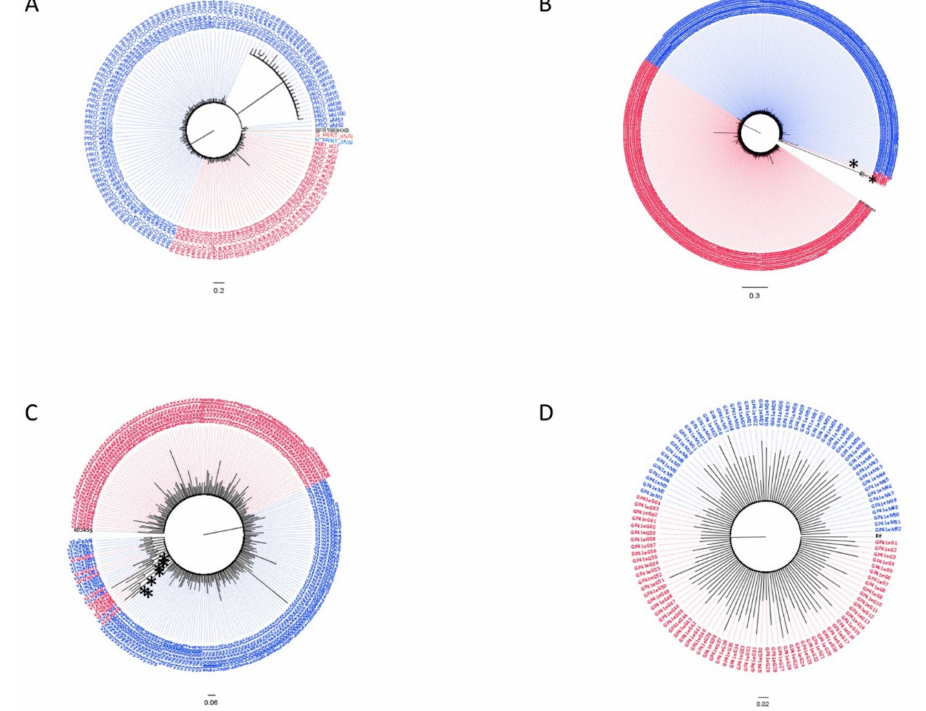
Figure 2. Bayesian trees for quasispecies of the HIV protease ( A ), RT ( B ), V1V2 ( C ) and gp41 ( D ) regions from the male (G, red color) and female (M, blue color) partners of the couple based on the analyses of whole-blood samples obtained during treatment. Significantly different clusters are indicated with an